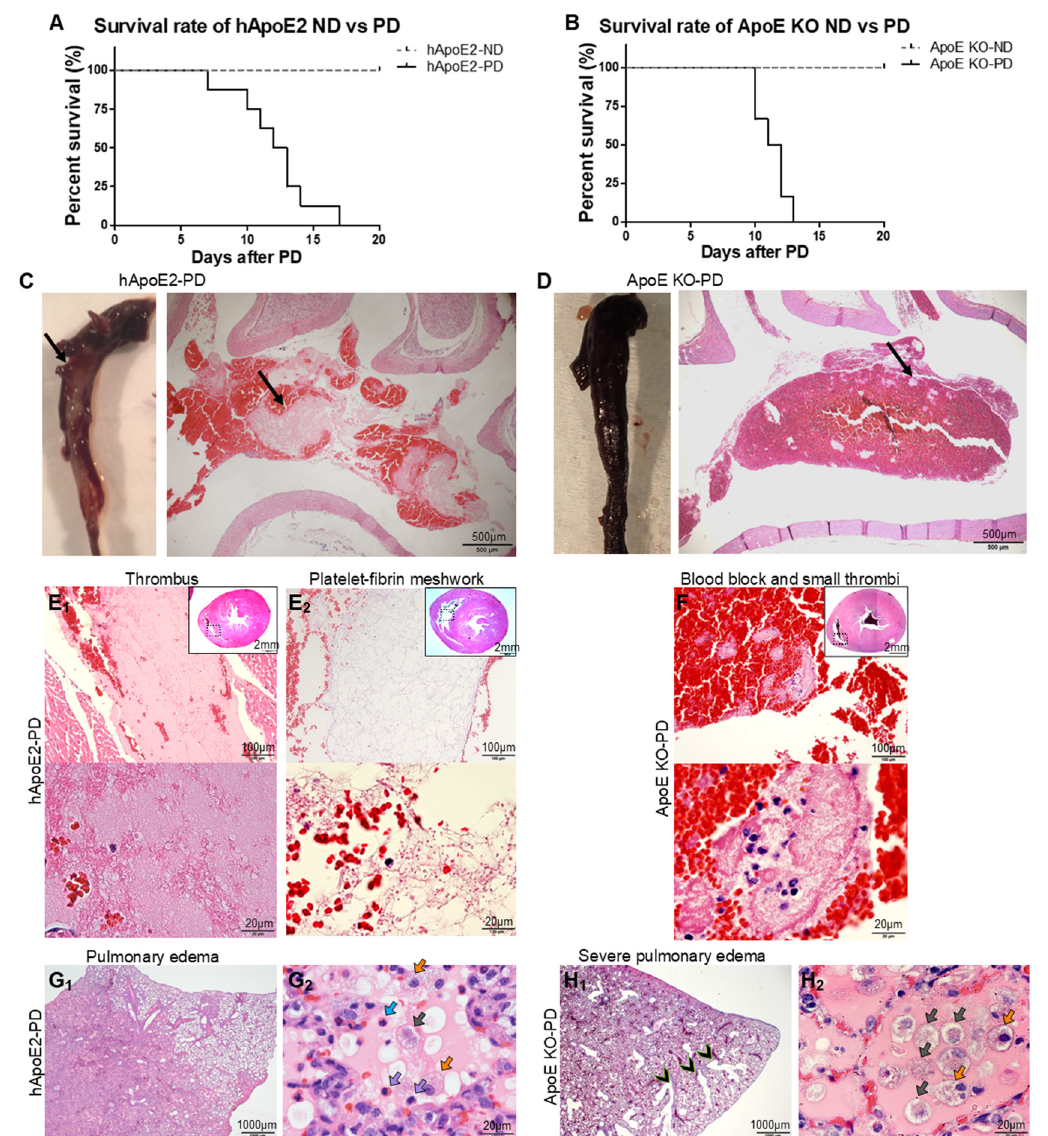
Figure 6. Survival rates and possible reasons for the death of hApoE2-PD and ApoE KO-PD rats. ( A , B ) The survival rates of hApoE2 and ApoE KO rats fed with the ND or PD are plotted and compared (hApoE, n = 8 each group; ApoE KO, n = 6 each group). ( C ) White color fatty embolus was detected in formalin-fixed hApoE2-PD aorta from autopsy (left gross image). Such fatty embolus was HE stained after paraffin preparation, shown in the right photomicrograph image. Black arrow indicates the fatty embolus in the aorta. ( D ) ApoE KO-PD aorta full of blood clot was HE stained. Blood cells were red stained, and small emboli were pink stained (black arrow). ( E 1 , E 2 ) Representative right ventricles of hApoE2-PD rats were HE stained. ( F ) Representative right ventricle of ApoE KO-PD rat was HE stained. Representative HE-stained slices of the hApoE2-PD ( G 1 , G 2 ) and ApoE KO-PD ( H 1 , H 2 ) lungs are shown. Neutrophils (blue), monocytes (purple), type II pneumocytes or alveolar macrophages (orange), and cell debris (gray).